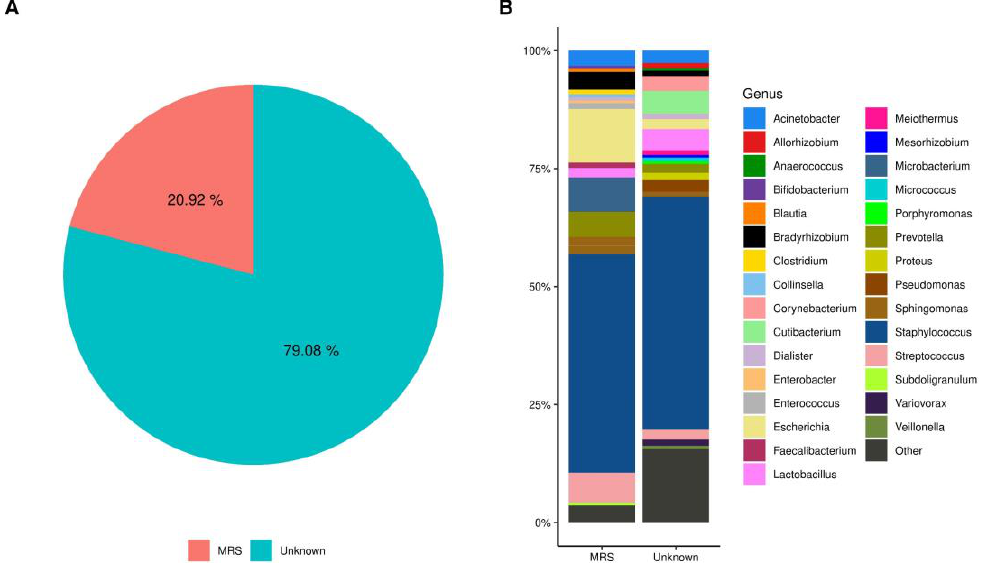
Figure 5. SourceTracker analysis of the possible origin of bacteria in human colostrum. ( A ) Microbial source tracker analysis showing the proportion of bacteria identified in HC (human colostrum) classified by source ( p < 0.001, Wilcoxon signed-rank test). The red color sector indicates that 20.92% of the bacterial taxa have a probable origin in the MRS (mother rectal swab), while 79.08% have an unknown origin. ( B ) Relative abundance in the percentage of most common bacterial taxa found in the mother’s HC is classified by SourceTracker Gibbs analysis as “MRS and Unknown”. The names of genera are indicated by colored legends on the right side of the graphic (Supplementary Materials Table S9).